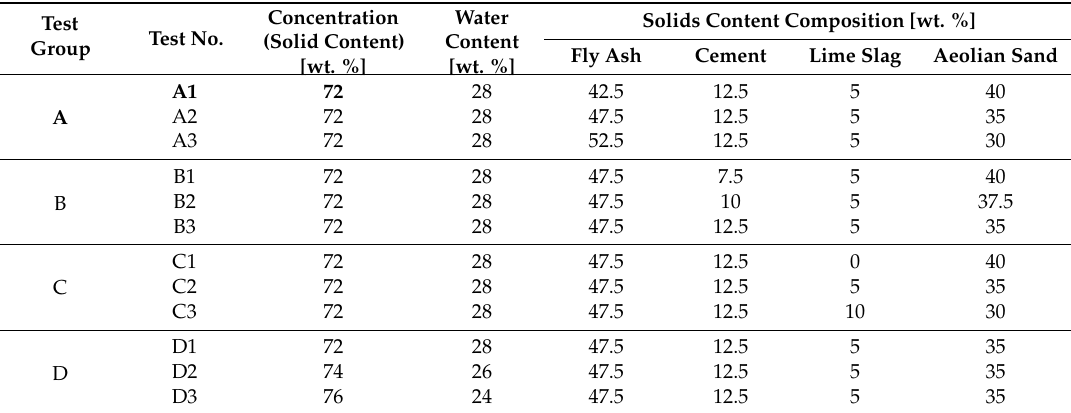
Table 2. Scheme of proportioning